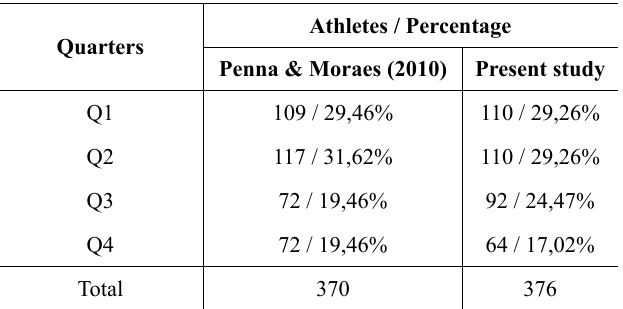
Table 3 – Comparison between results from Penna and Moraes (2010) and the present study.